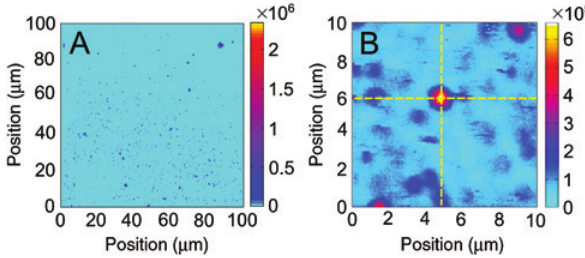
Figure 1: Archetypal confocal scans of the ZnO NP sample annealed at 700 ° C.